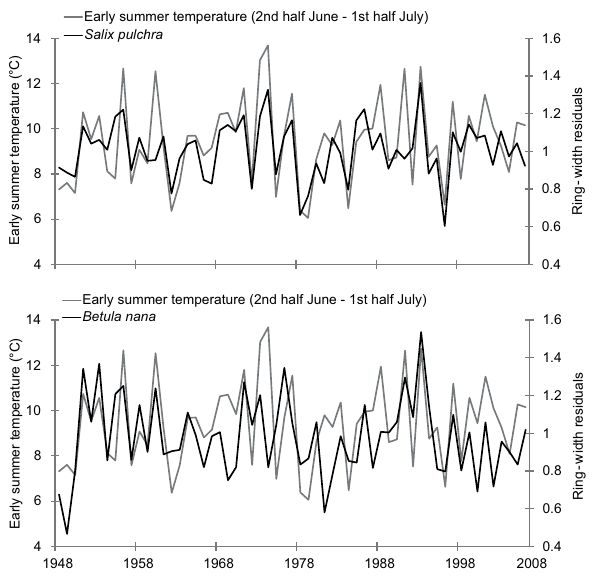
Fig. 2. The black lines show Salix pulchra and Betula nana residual ring-width chronologies. The grey lines show the mean summer temperature (17 June–19 July) for the period 1948–2006.